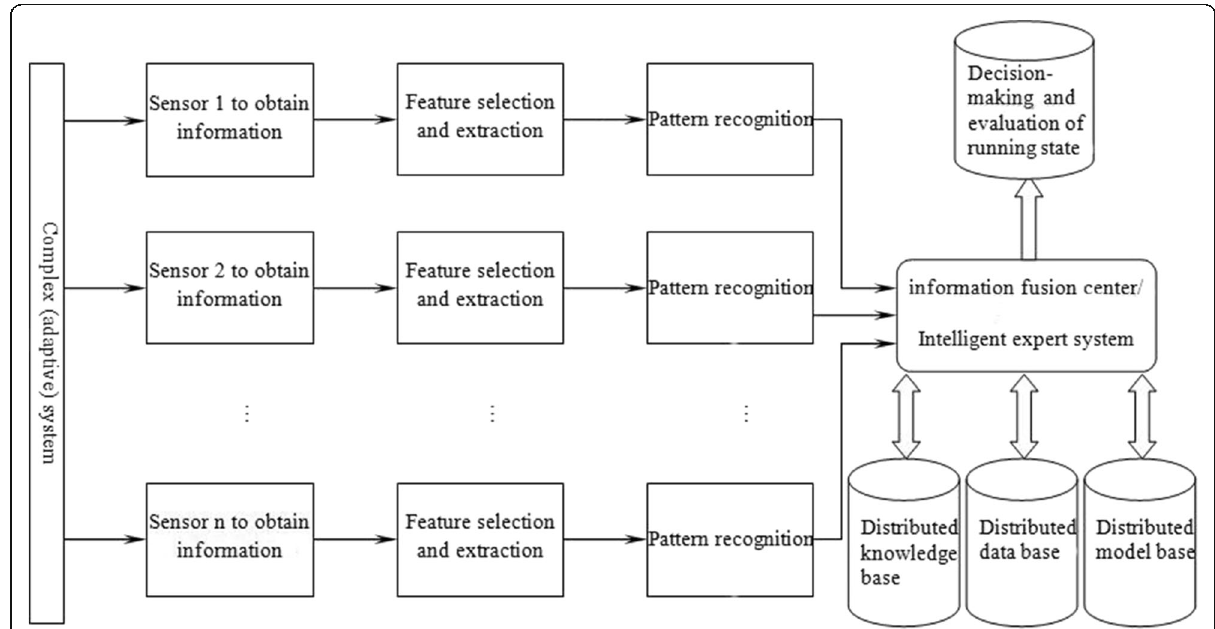
Fig. 2 The information fusion system framework of multi-sensor